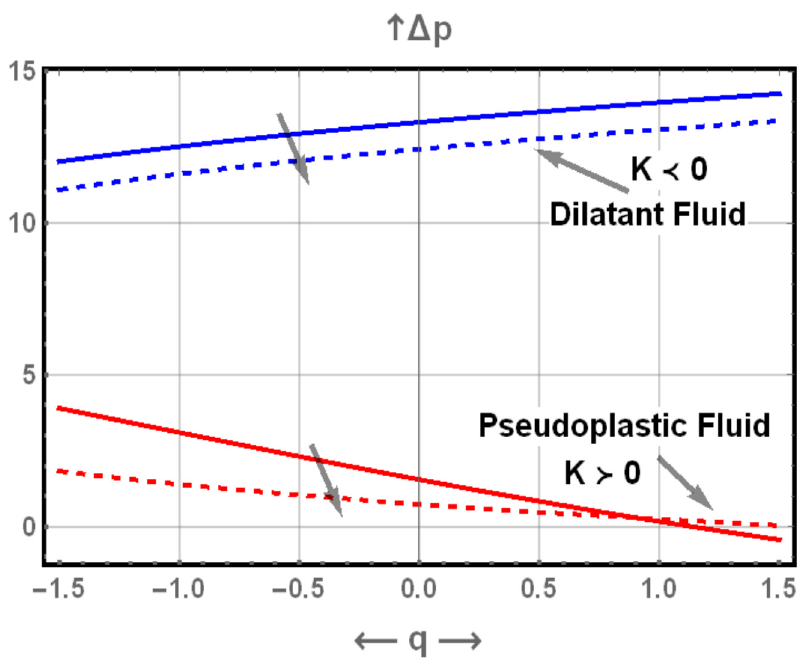
Figure 27. Display of pressure rise vs. volume flow rate for different values of 𝛼 (cid:4593) .